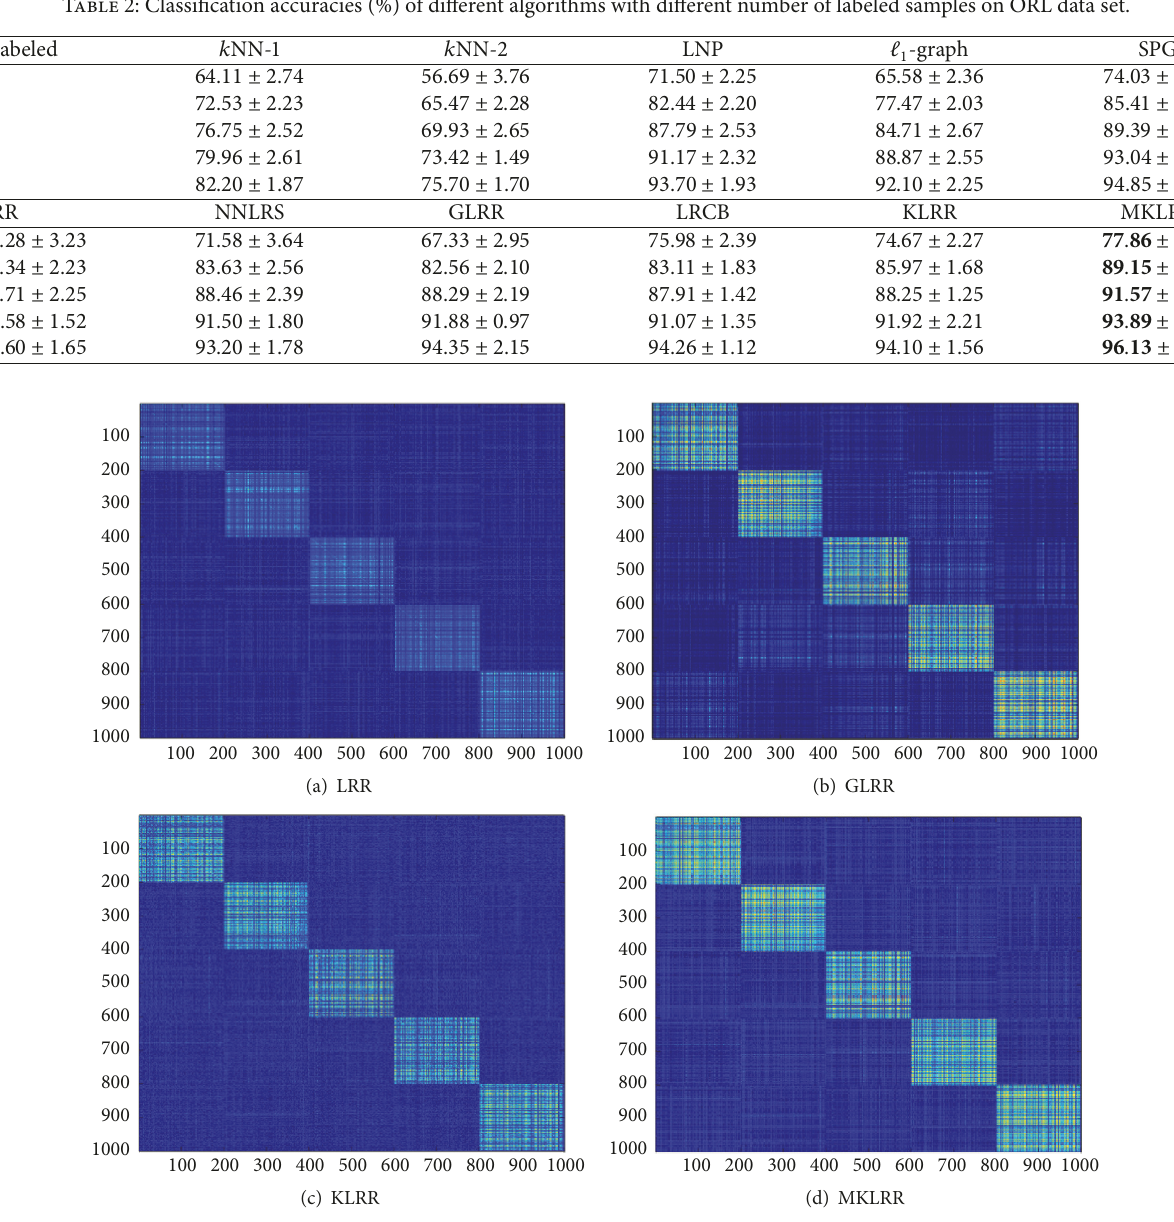
Table 2: Classification accuracies (%) of different algorithms with different number of labeled samples on ORL data set.